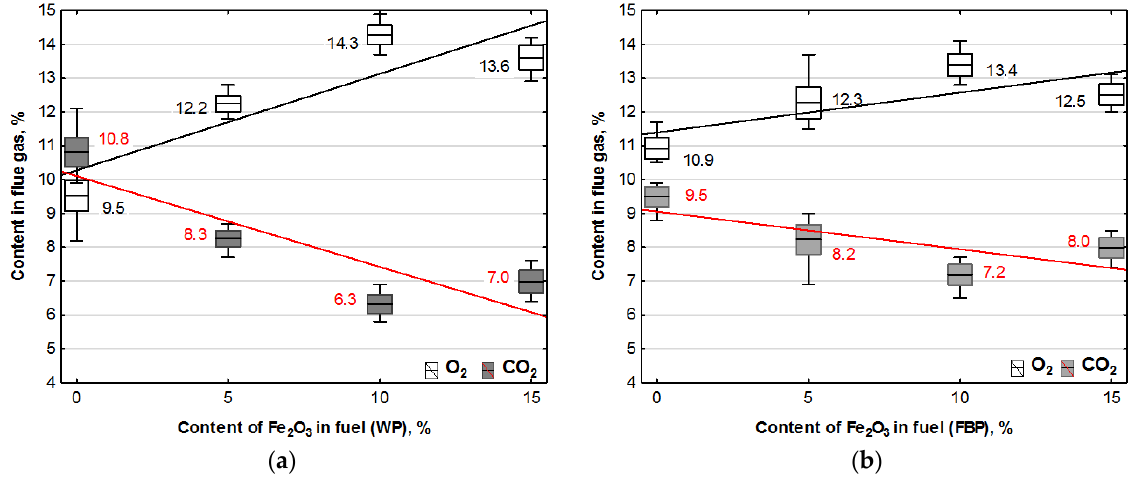
Figure 3. Impact of Fe 2 O 3 content in fuel on oxygen and carbon dioxide contents in flue gases from the combustion of: ( a ) Wood pellets (WP); and ( b ) Furniture board pellets (FBP).